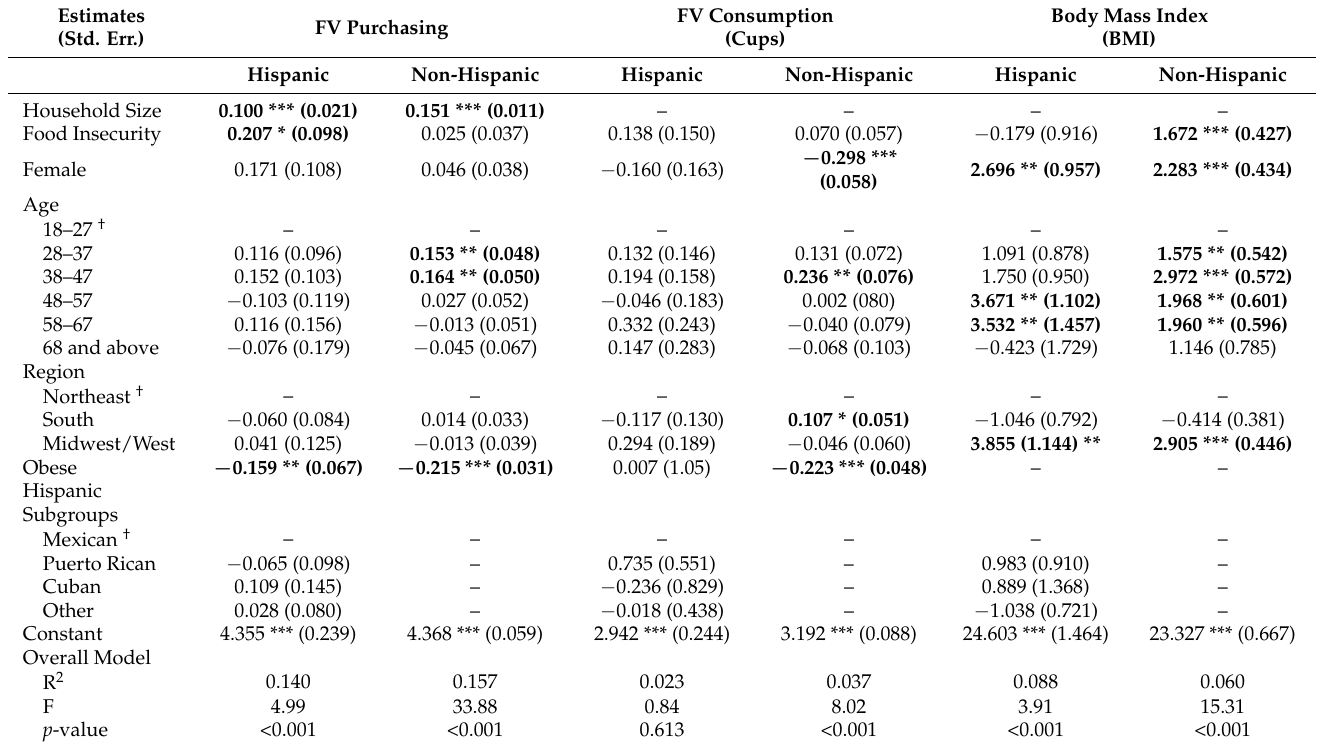
Table 2. Regression Analyses Predicting Fruit and Vegetable Purchasing, Consumption, and BMI in Hispanic and non- Hispanic groups. Estimates (Std.